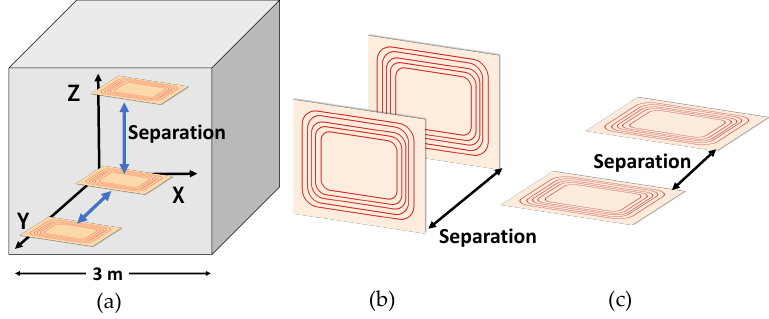
Figure 12. The test conditions of the proposed separation-independent WPT: ( a ) the 3D test volume, ( b ) separation between aligned coils, ( c ) separation between misaligned coils.